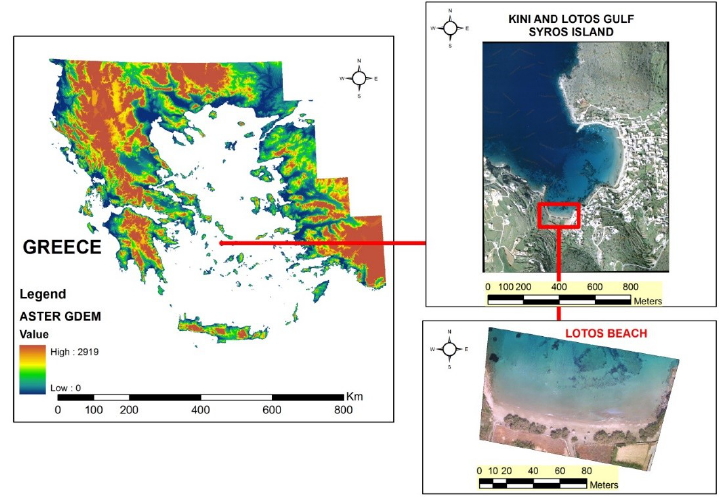
Figure 1. The study area. Beachrock lies in Lotos beach, at Kini and Lotos gulf, Syros Island, Aegean Sea, Greece. Left : ASTER Global Digital Elevation Model (ASTER GDEM) covering the whole country at 1:7,500,000 scale. Upper right : Orthophoto of the broader area from the Greek Cadastre with 25 cm spatial resolution at 1:15,000 scale. Lower right : Orthophoto from the Lotos beach created from the unmanned aerial vehicle (UAV) images with 1 cm spatial resolution at 1:2000 scale.